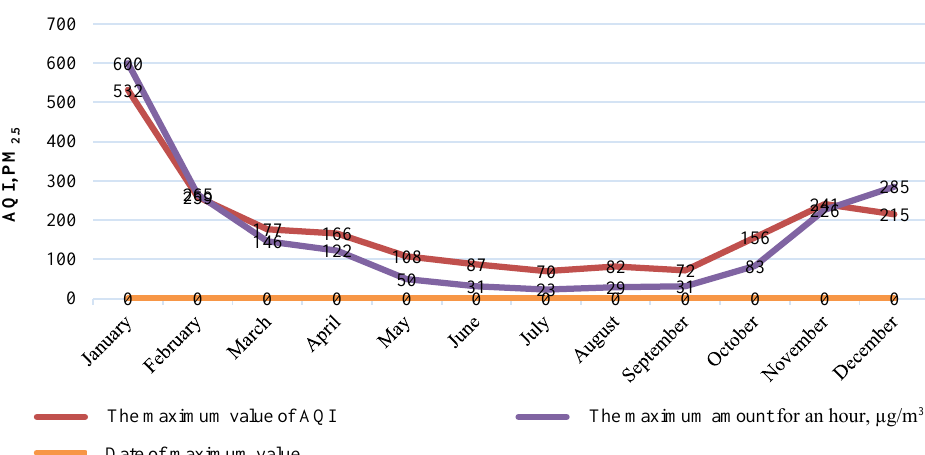
Fig. 2. Chart of measured values for AQI, PM 2.5 in Prishtina,